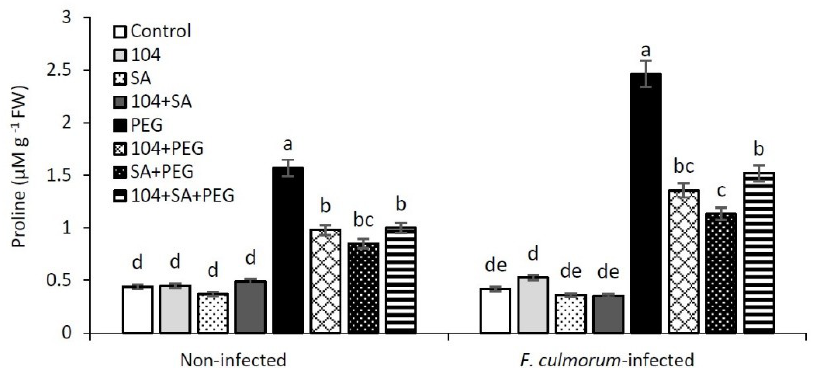
Figure 8. Effect of B. subtilis 10–4 (104) (10 5 CFU mL −1 ), salicylic acid (SA) (0.05 mM), and B. subtilis 10–4 + SA (104 + SA) on the content of osmoprotectant proline in non-infected wheat plants and wheat plants infected with F. culmorum ( F. culmorum -infected) under normal and drought conditions. Fourteen-day-old seedlings; drought stress (12% PEG) exposure time—11 days; time after infection with F. culmorum —10 days. The error bars show the average of three replicates ± SEM. Different letters indicate a significant difference between the average values for p < 0.05.